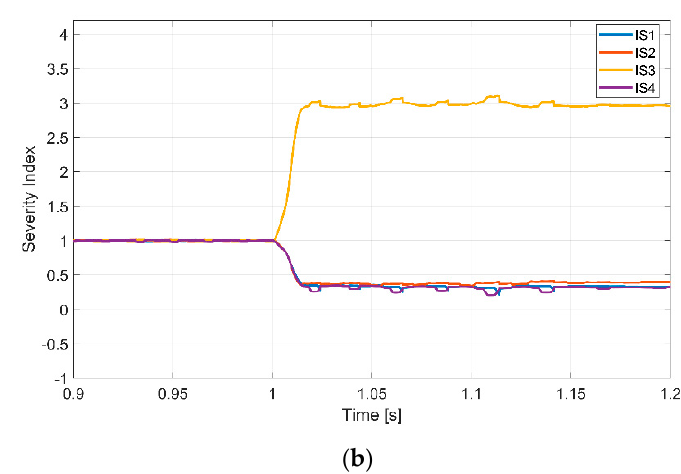
Figure 15. Diagnostic variables associated with the motor winding currents of the SRM in normal operation and short-circuit failure of power device ( a ) 60 rpm and S 1 D ( b ) 600 rpm and S 1 C (simulation result).